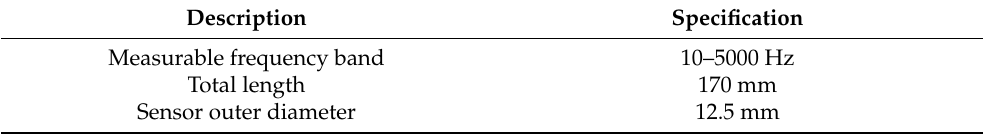
Table 3. Specifications of the sonic tension meter used in the experiment.